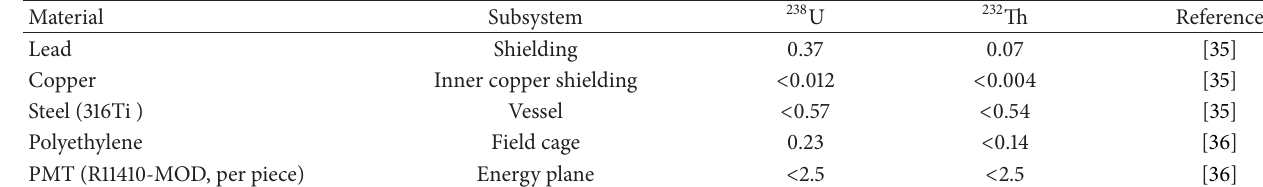
Table 3: Activity (in mBq/kg) of the most relevant materials used in NEXT.